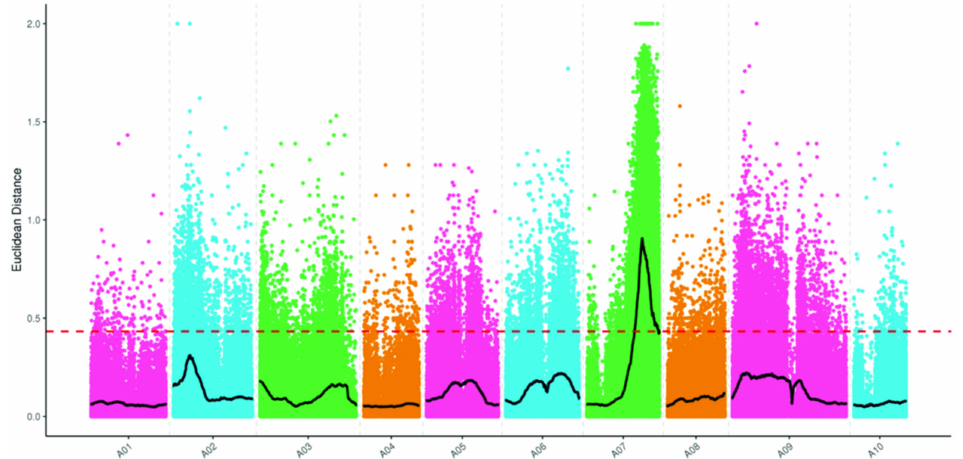
Figure 3. Mapping BrEb-1 by the Euclidean distance (ED) algorithm, using the SNP approach. The abscissa represents the chromosome name; the colored dots represent the ED value of each SNP locus; the black line indicates the fitted ED value; the red dashed line represents the significant correlation threshold (threshold = 0.43). The higher the ED value, the greater the